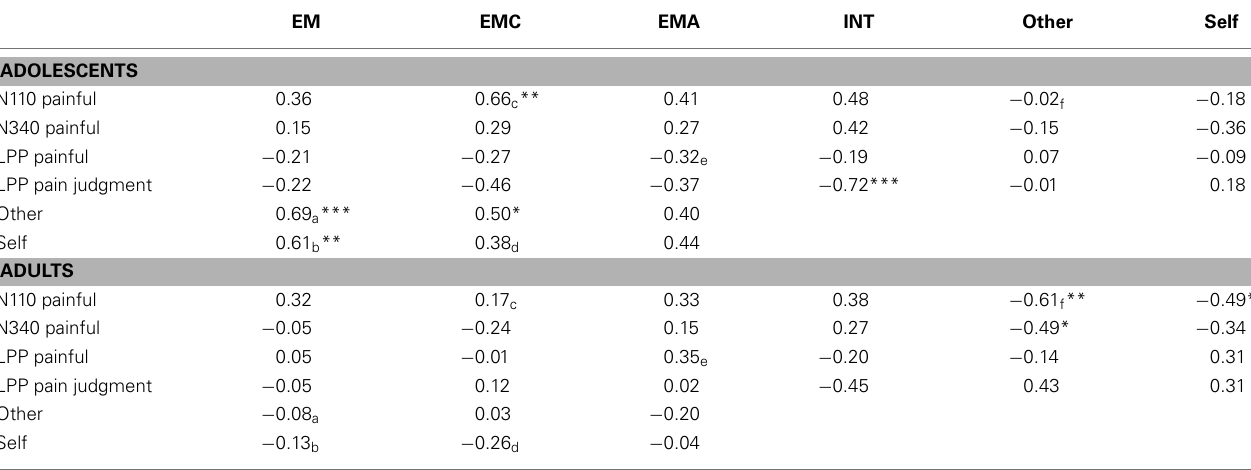
Table 4 | Correlations between ERPs amplitudes and behavioral measures in adults and